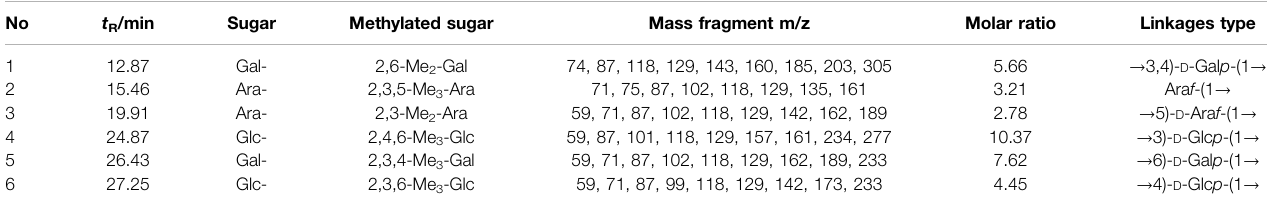
TABLE 2 | Analysis of APS-I methylation